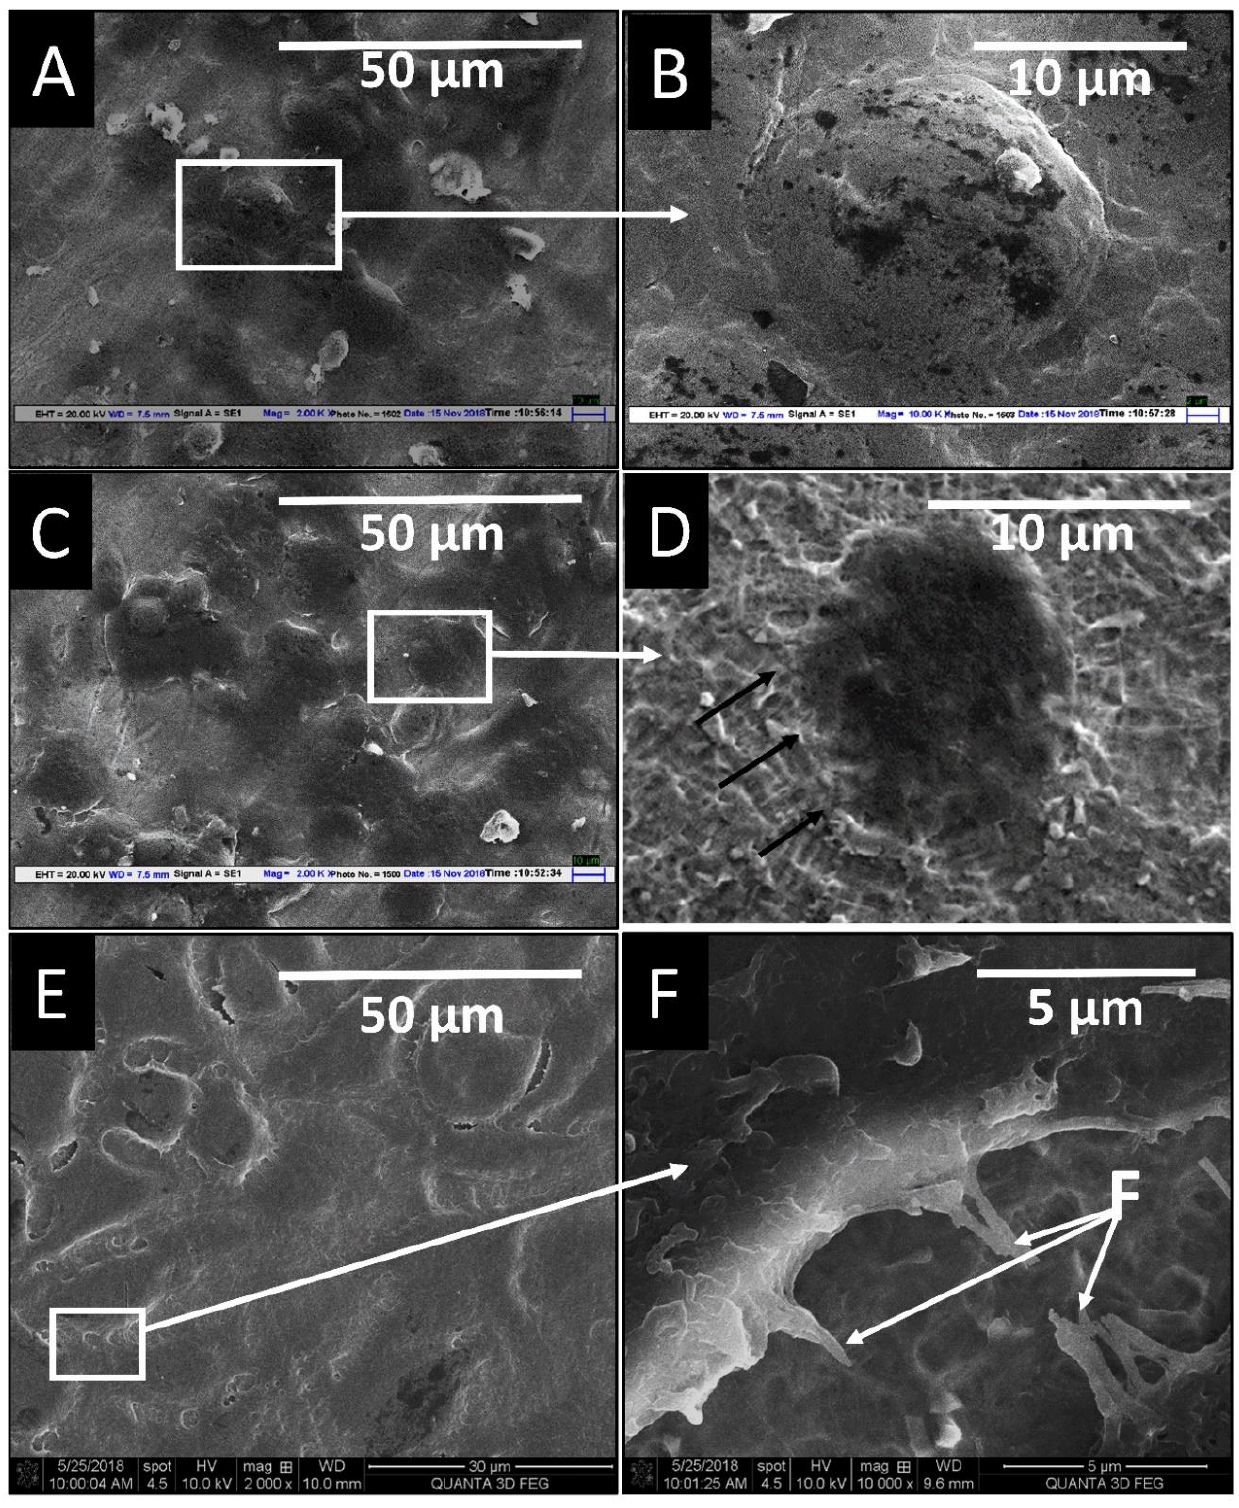
Figure 10. SEM images of MG 63 cells on machined ( A , D ), RT etched ( B , E ), and HT etched ( C , F ) surfaces after 24 h of culture (F — filopodia).